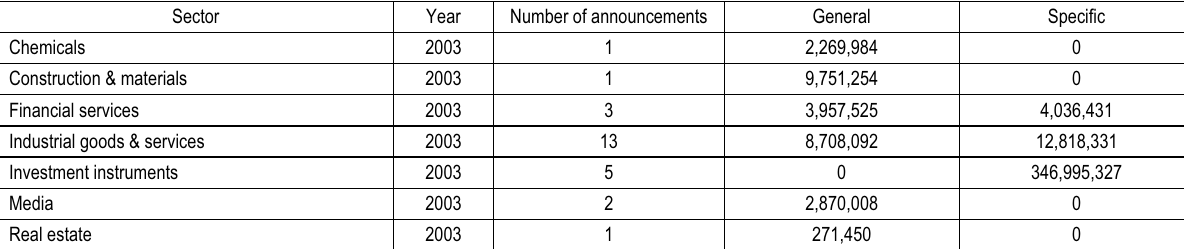
Table 2. Total share repurchase announcements per sector per calendar year for the